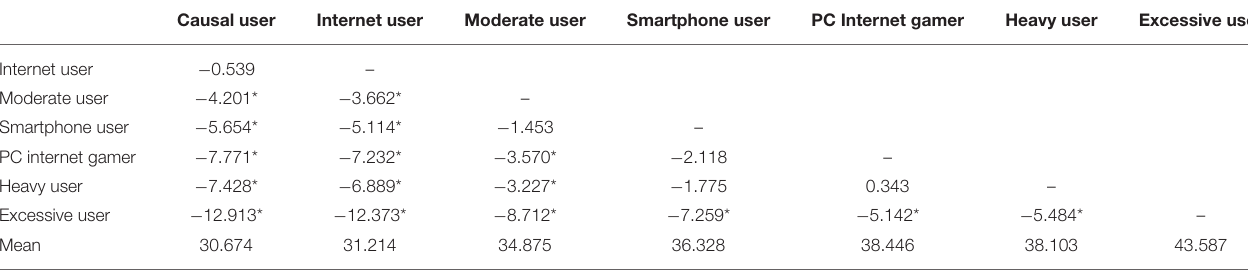
TABLE 7 | ANCOVA result comparing problematic game usage among profiles (mean difference).